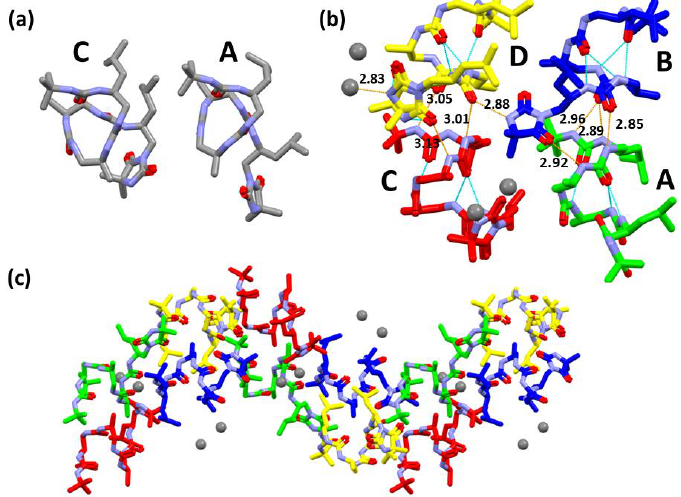
Figure 5. Crystal structure of compound 2a : ( a ) two (A and C) of four independent molecules in the asymmetric unit, showing different positions of the hydantoin ring, ( b ) the length of intermolecular hydrogen bonds (orange), green—A, blue—B, red—C, yellow—D and ( c ) packing of oligourea hydantoin 2a .